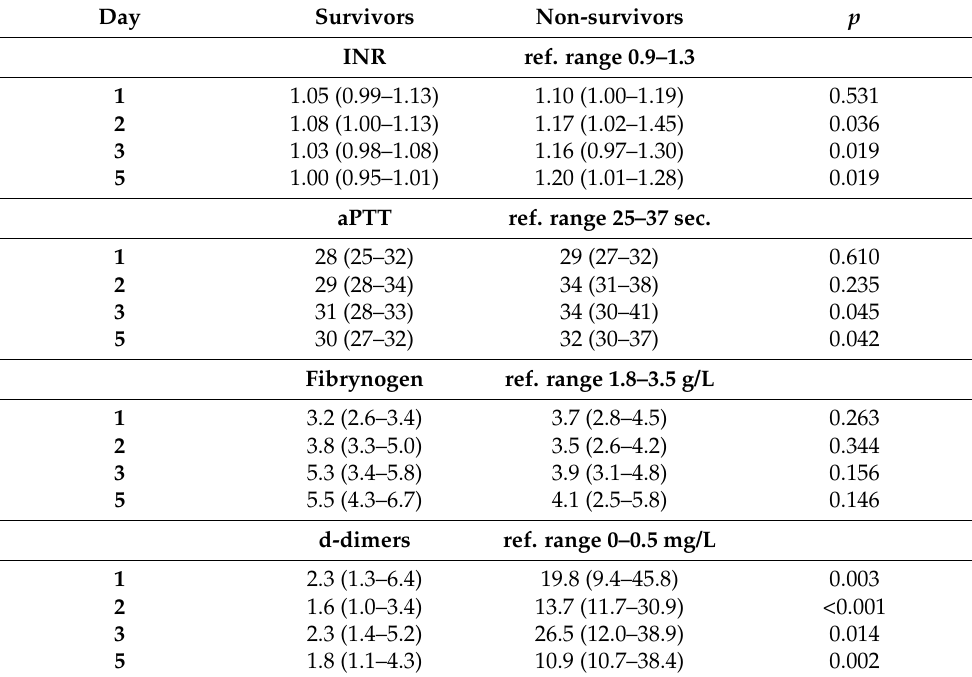
Table 2. Coagulation parameters in Survivors and Non-survivors measured on days 1, 2, 3 and 5. Day